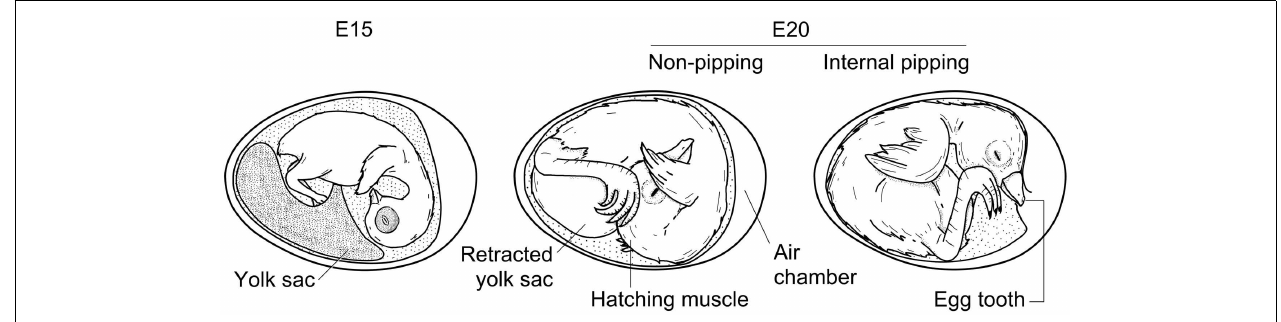
FIGURE 3 | Schematic comparison of the chicken embryo at days 15 and 20 of development, showing yolk sac retraction and internal pipping . Drawing by Sylvia